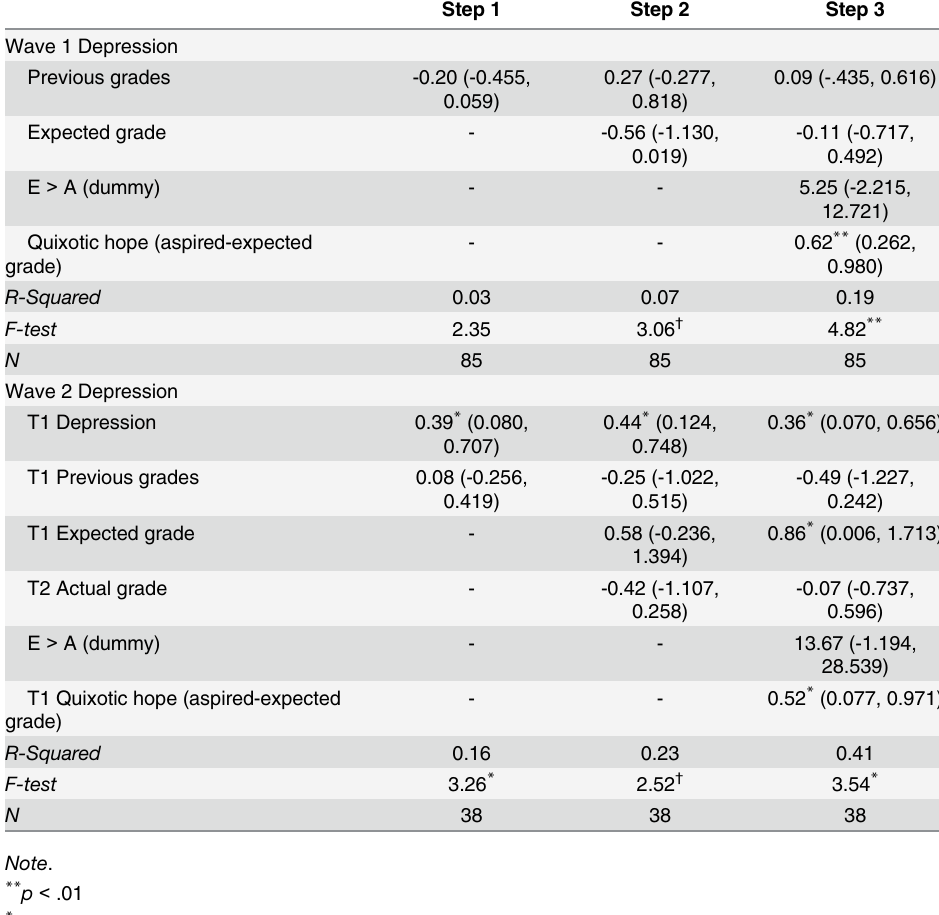
Table 3. Results of regression analyses for Study